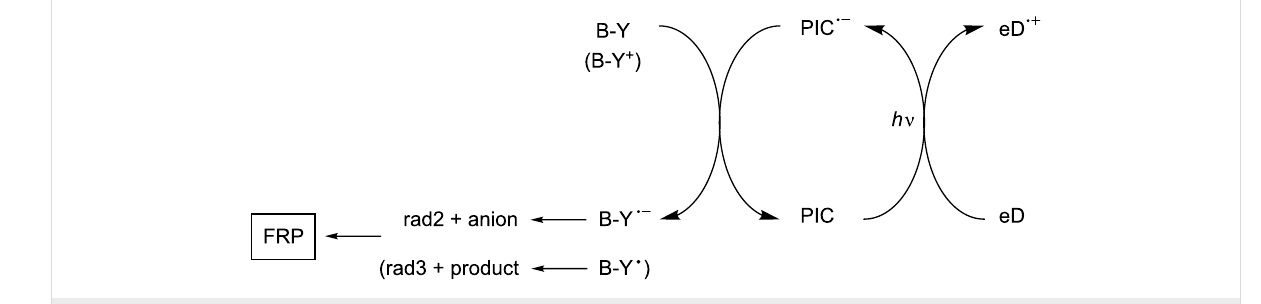
Scheme 5: Reaction mechanisms for the system PIC/eD/B-Y.